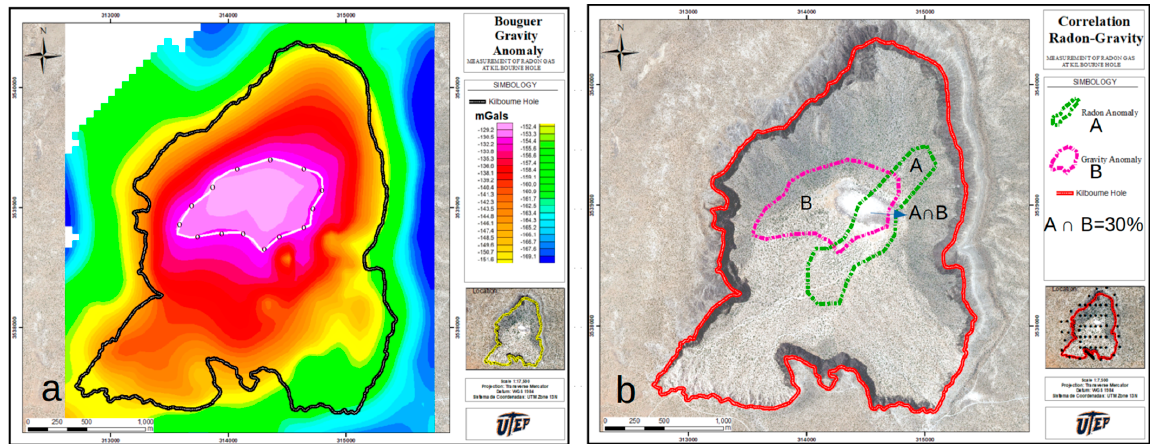
Figure 5. ( a ) Bouguer gravity anomaly map of Kilbourne Hole. The white, circled contour delimits the gravity anomaly, modified from the original data provided in [12]. ( b ) Anomaly of overlapping regions A ∩ B, related to Rn (A) and gravity data (B). It can also be seen that the overlapping extension of the crater surface (white central region), provided by the intersecting area (A ∩ B), covers half. The degree of correspondence of the C Rn anomaly with the gravity anomaly provides a clear view of the overlapping degree for the selected regions indicated by A and B; the analysis indicates that ~30% corresponds to the intersecting area, (A ∩ B). The value was